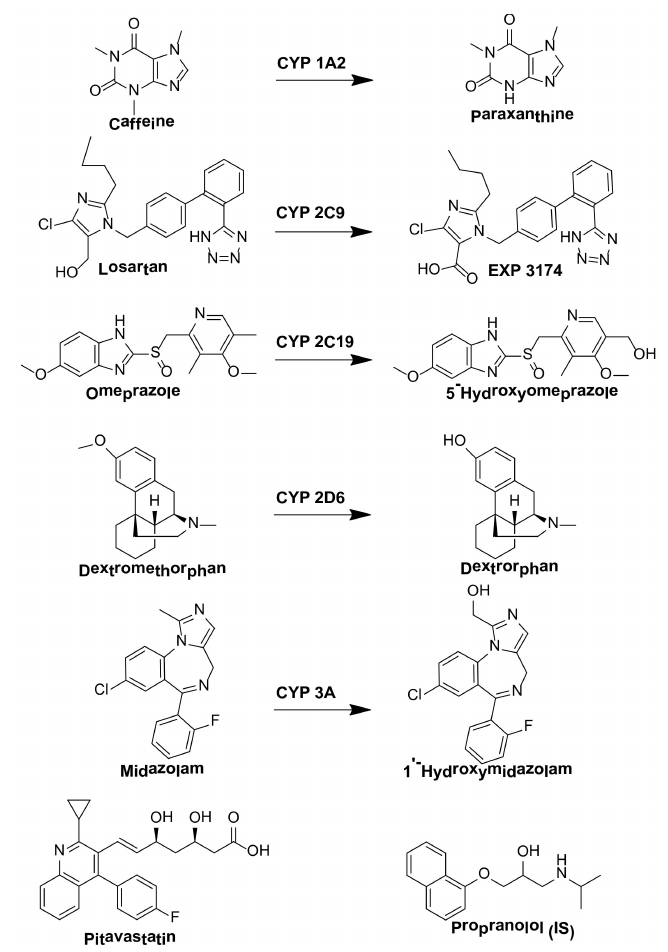
Figure 1. Chemical structure of organic anion transporting polypeptide (OATP) and cytochrome P450 (P450) probe drugs, their metabolites, and propranolol (internal standard [IS]) used in this